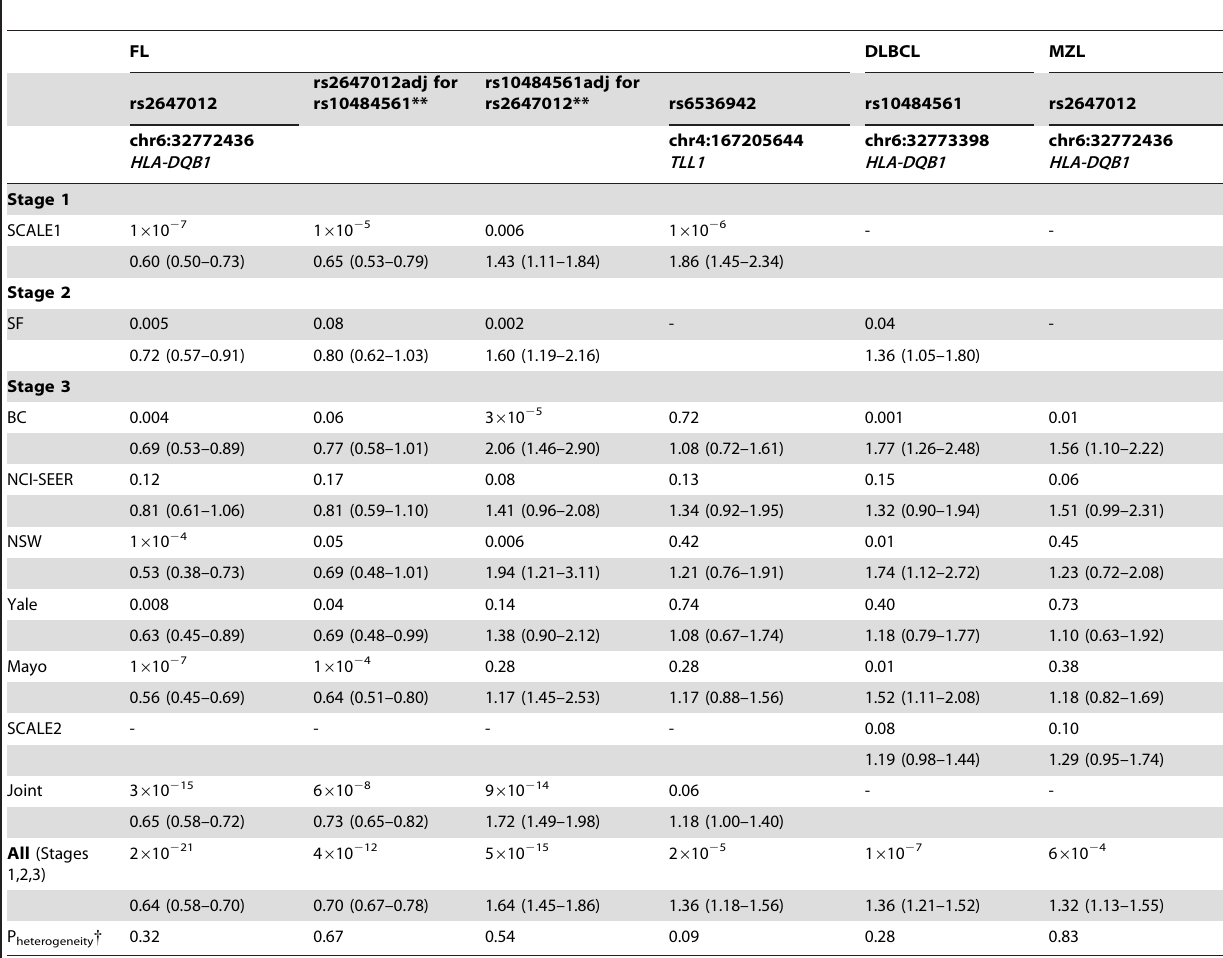
Table 2. Summary of main findings in genome-wide association study (GWAS) and validation stages in risk* of follicular lymphoma (FL), diffuse large B-cell lymphoma (DLBCL), or marginal zone lymphoma (MZL), per study and